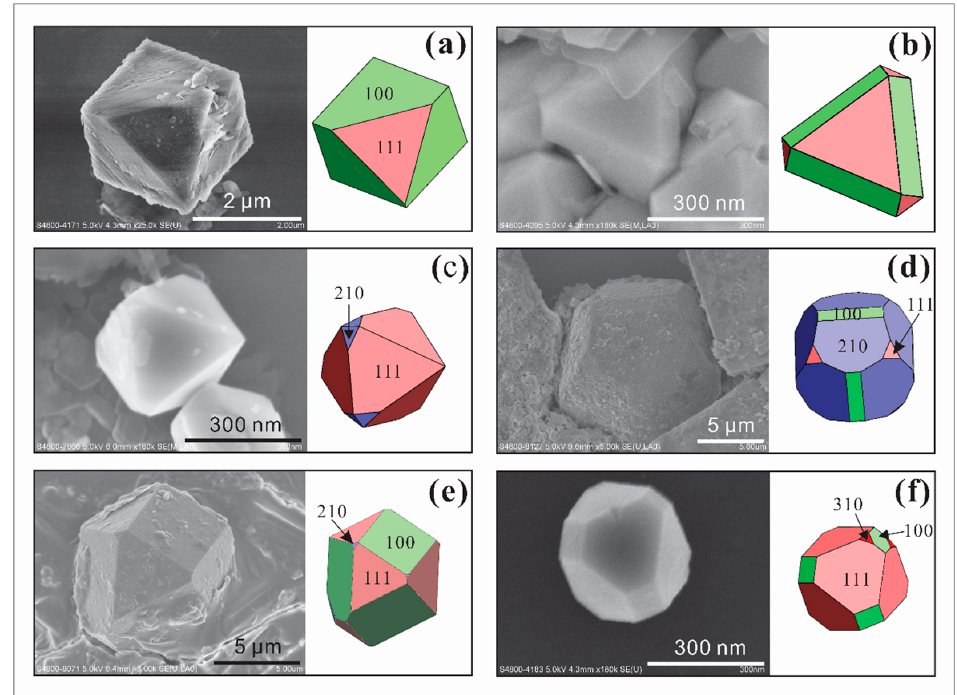
Figure 6. SEM images of single pyrite with combinations of a{100}, o{111}, e{210}, and f{310} faces and their corresponding crystal shapes (color drawings on the right) which show incomplete transformations between two forms result in face going missing during crystal development ( a – f ).